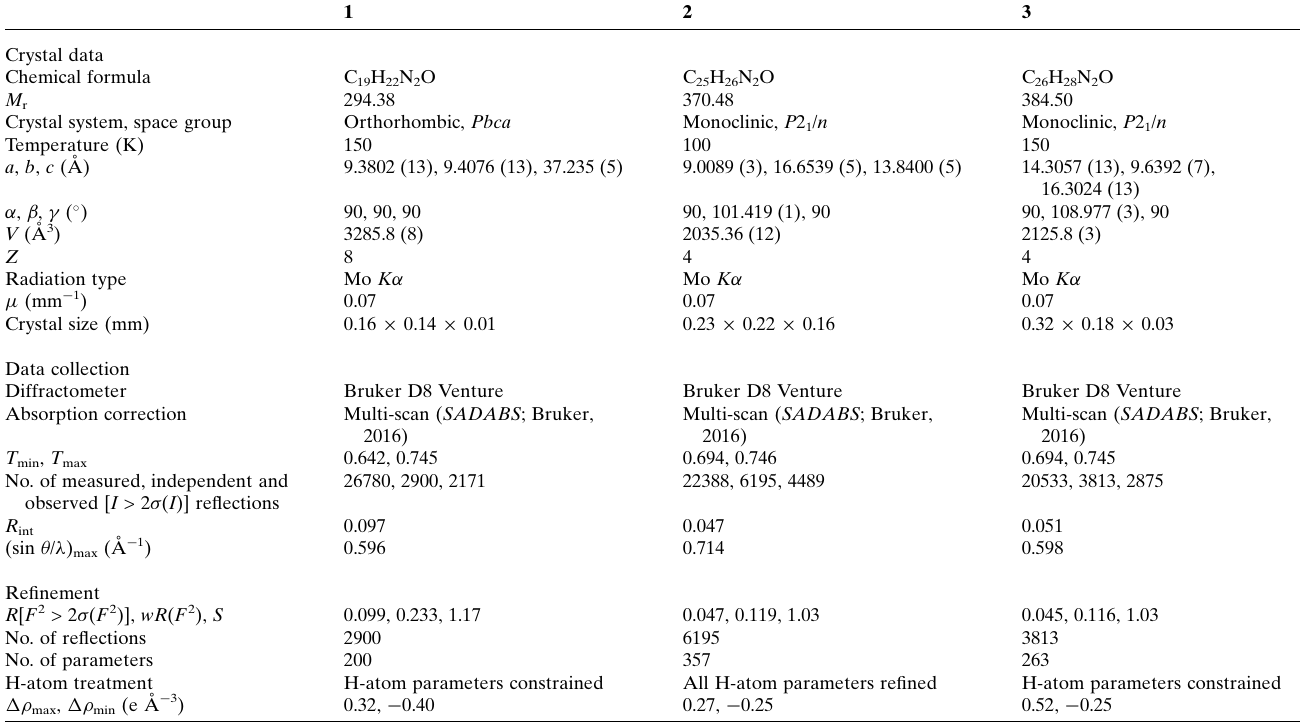
Table 2 Experimental details.